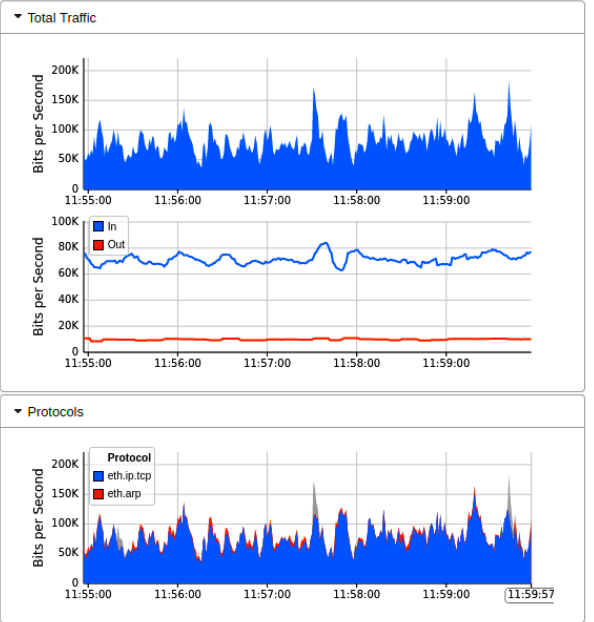
Figure 8. Network bandwidth dashboard during real-time normal traffic